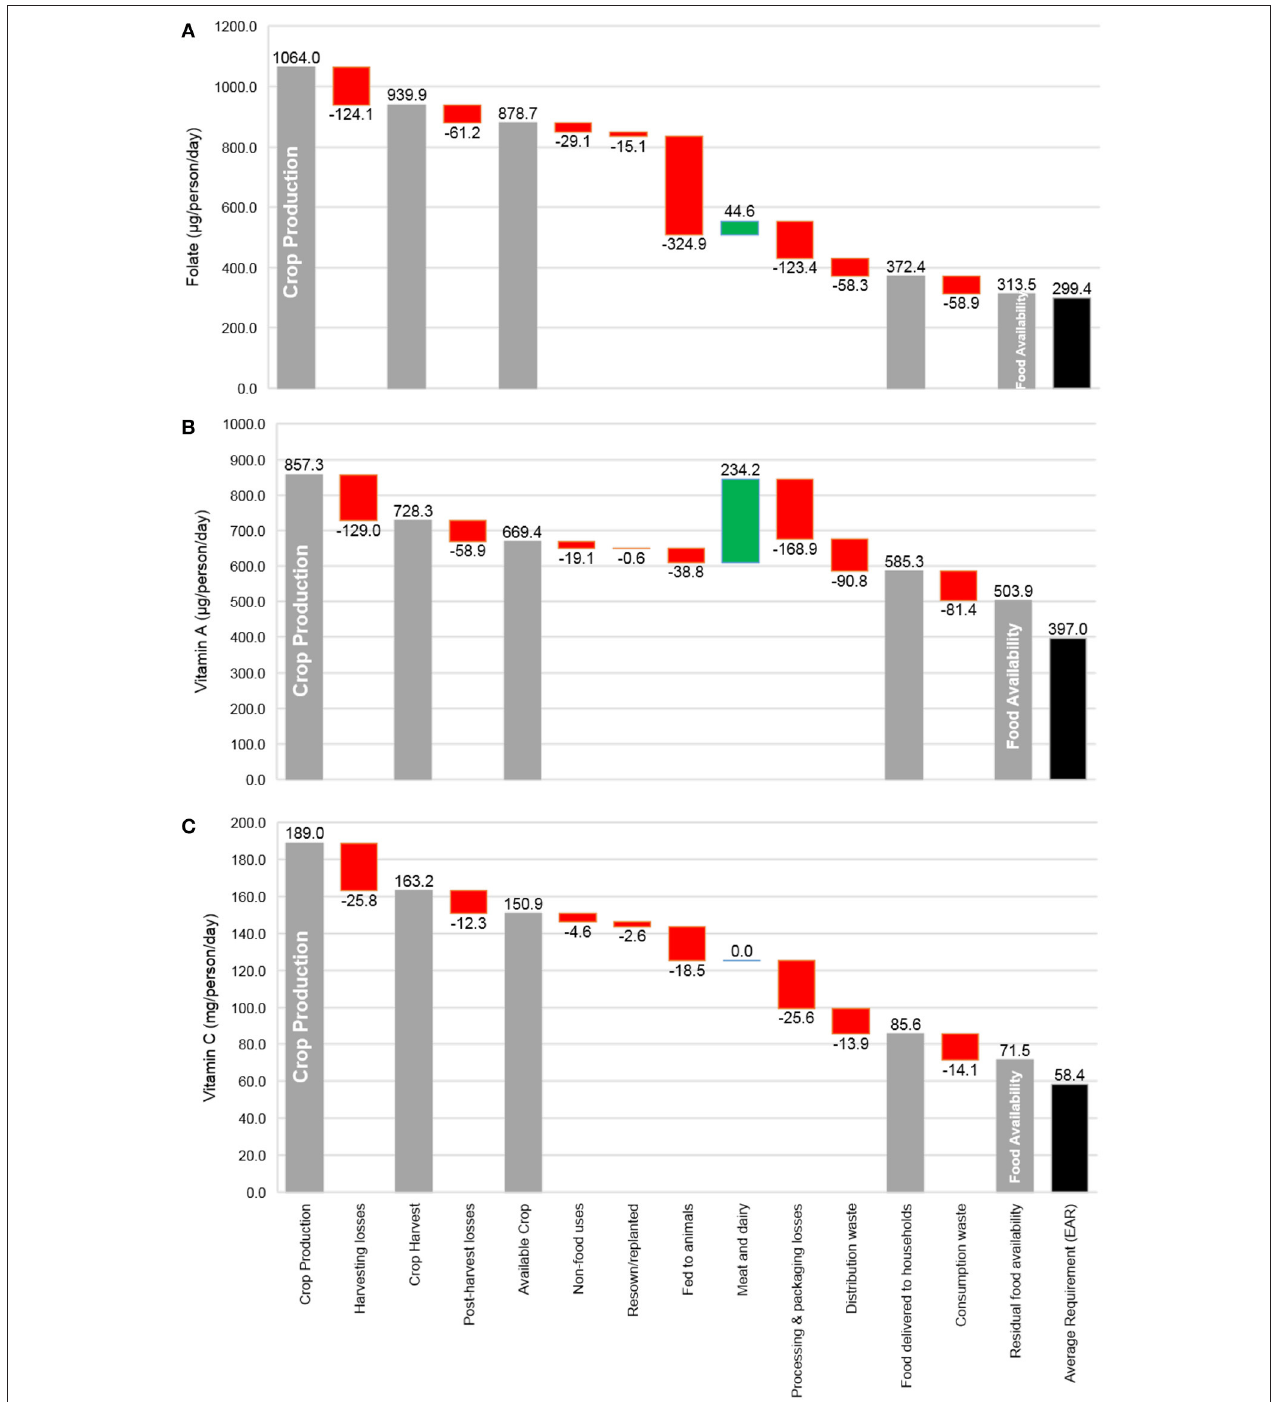
FIGURE 3 | Production and losses of micronutrients in the global food system from “field to fork” in 2011. Food pathways in (A) folate; (B) vitamin A; and (C) vitamin C from crop production to residual food availability, normalized to average per capita levels assuming equal distribution. Red bars (negative numbers) indicate food system losses; green bars indicate meat and dairy production; and gray bars indicate macronutrient availability at intermediate stages of the chain, with the estimated average requirement shown in black.